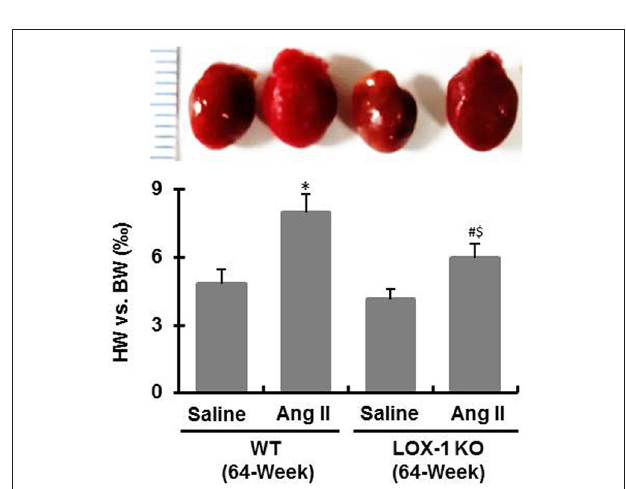
FIGURE 4 | The ratio of heart weight to body weight of each group of mice following infusion with Ang II or saline for 4 weeks. n = 6 /group. * P < 0.05, vs. WT + saline group; # P < 0.05, vs. LOX-1 KO + saline group; $ P < 0.05, vs. WT + Ang II